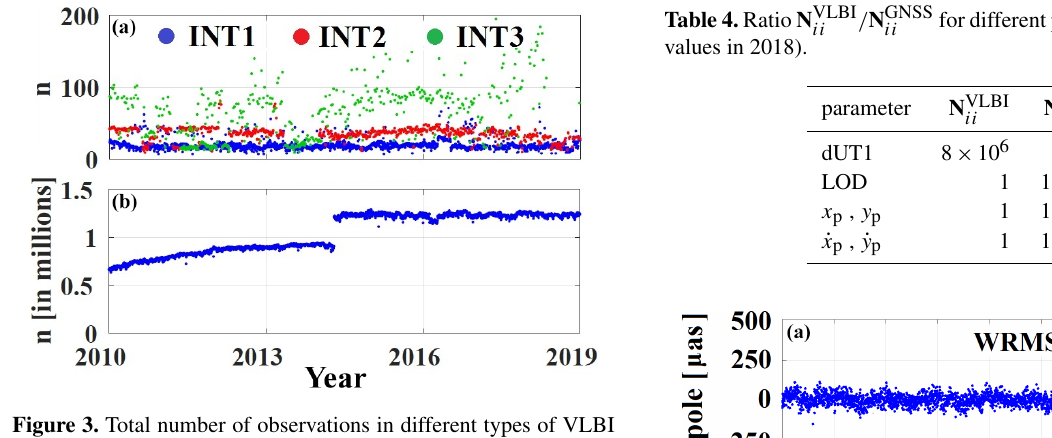
Figure 3. Total number of observations in different types of VLBI Intensive sessions (a) and GNSS solutions (b) .